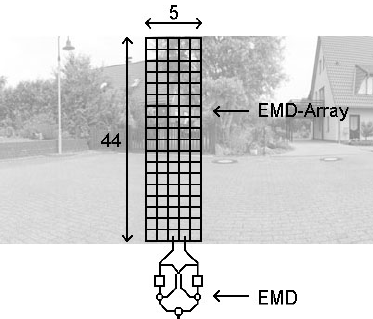
Figure 3. Moving EMD array. For the simulation tests an array of 44 × 5 input elements was used. Each element covers a 2 ◦ visual angle and applies a Gaussian shaped spatial low-pass filter ( σ = 1 . 5 ◦ ) to the input image. The simulated EMD array has a horizontal preferred direction, and consists of 176 EMDs. For the analysis, the EMD responses are spatially averaged. The observed intensity values of the input array change in time, depending on the horizontal velocity of the presented